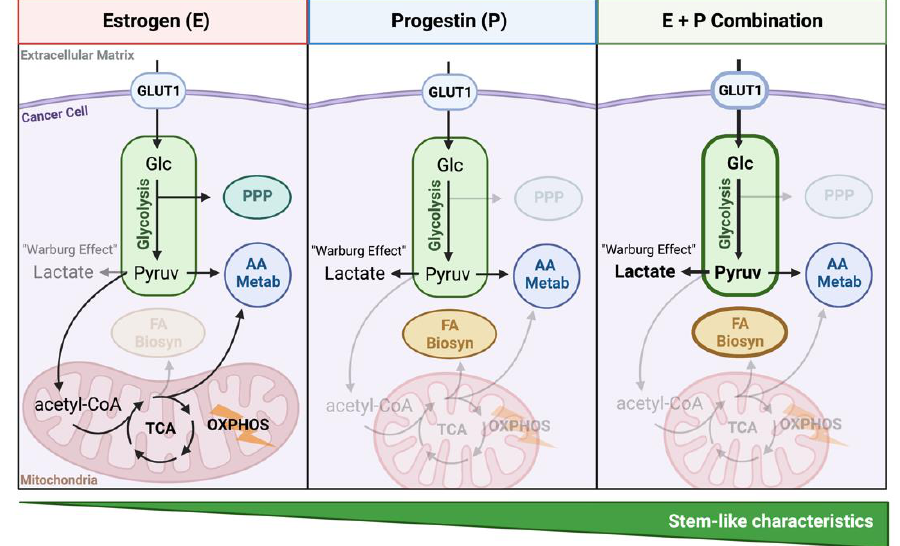
Figure 7. Summary schematic of the metabolic influence of estrogens (E) and progestins (P) on breast cancer cellular metabolism. Estrogens activate oxphos and pentose phosphate pathway (PPP) in a cell line specific manner. Progestins activate glycolysis, lactate production, and fatty acid biosynthesis. The combination further shifts cellular metabolism towards glycolysis and glycerolipid metabolism. Amino acid metabolism, AA Metab; Fatty acid biosynthesis, FA Biosyn; glucose, Glc; Glucose transporter 1, GLUT; oxidative phosphorylation, OXPHOS; pyruvate, Pyruv; tricarbocylic acid cycle, TCA.